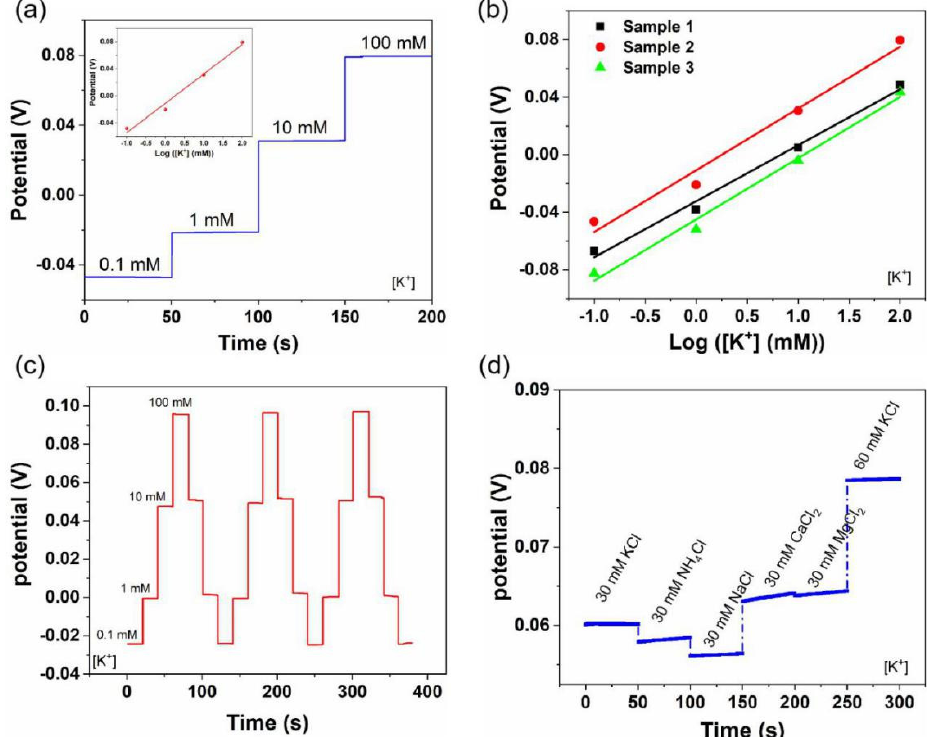
Figure 4. K + -sensing performance of flexible LIG-based sensors: ( a ) sensitivity, ( b ) reproducibility, ( c ) stability, and ( d ) selectivity. Inset in ( a ) is the corresponding calibration plot.